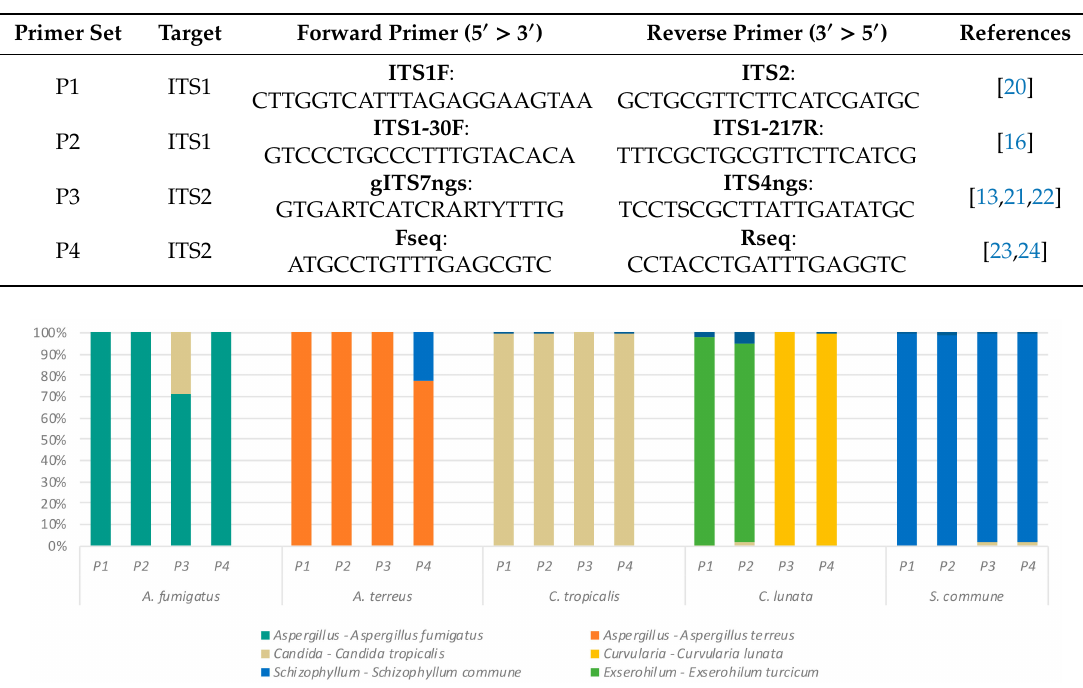
Figure 2. Analysis of classified ITS sequences derived from pure fungal cultures using di ff erent primer sets. Colored bars indicate the percentage of ITS reads mapped to indicated taxa; Aspergillus ( A. fumigatus / A terreus ), Candida ( C. tropicalis ), Curvularia ( C. lunata ), Schizophyllum ( S. commune ), and Exserohilum ( E. turcium